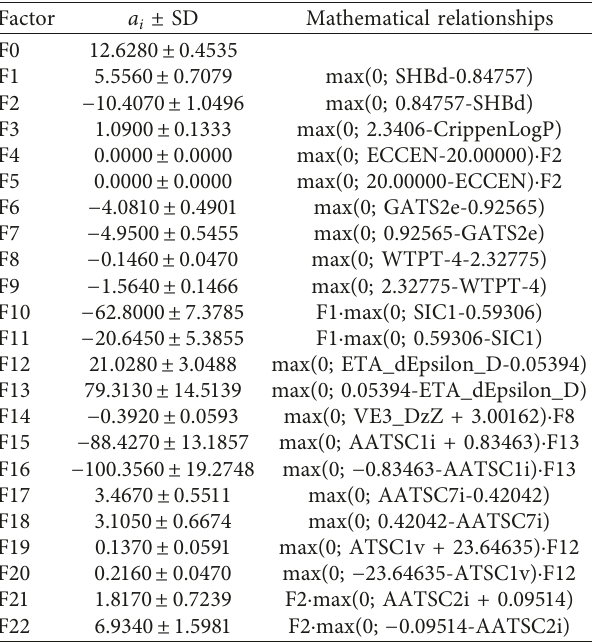
Table 3: MARSplines HB(25,2) model regression factors along with their